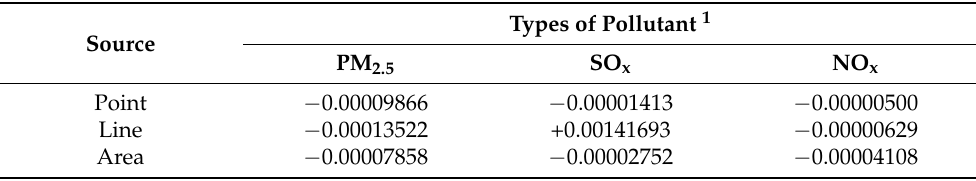
Table 4. The effect of a one-ton reduction in PM 2.5 , SO x and NO x on the concentration of PM 2.5 from different sources.